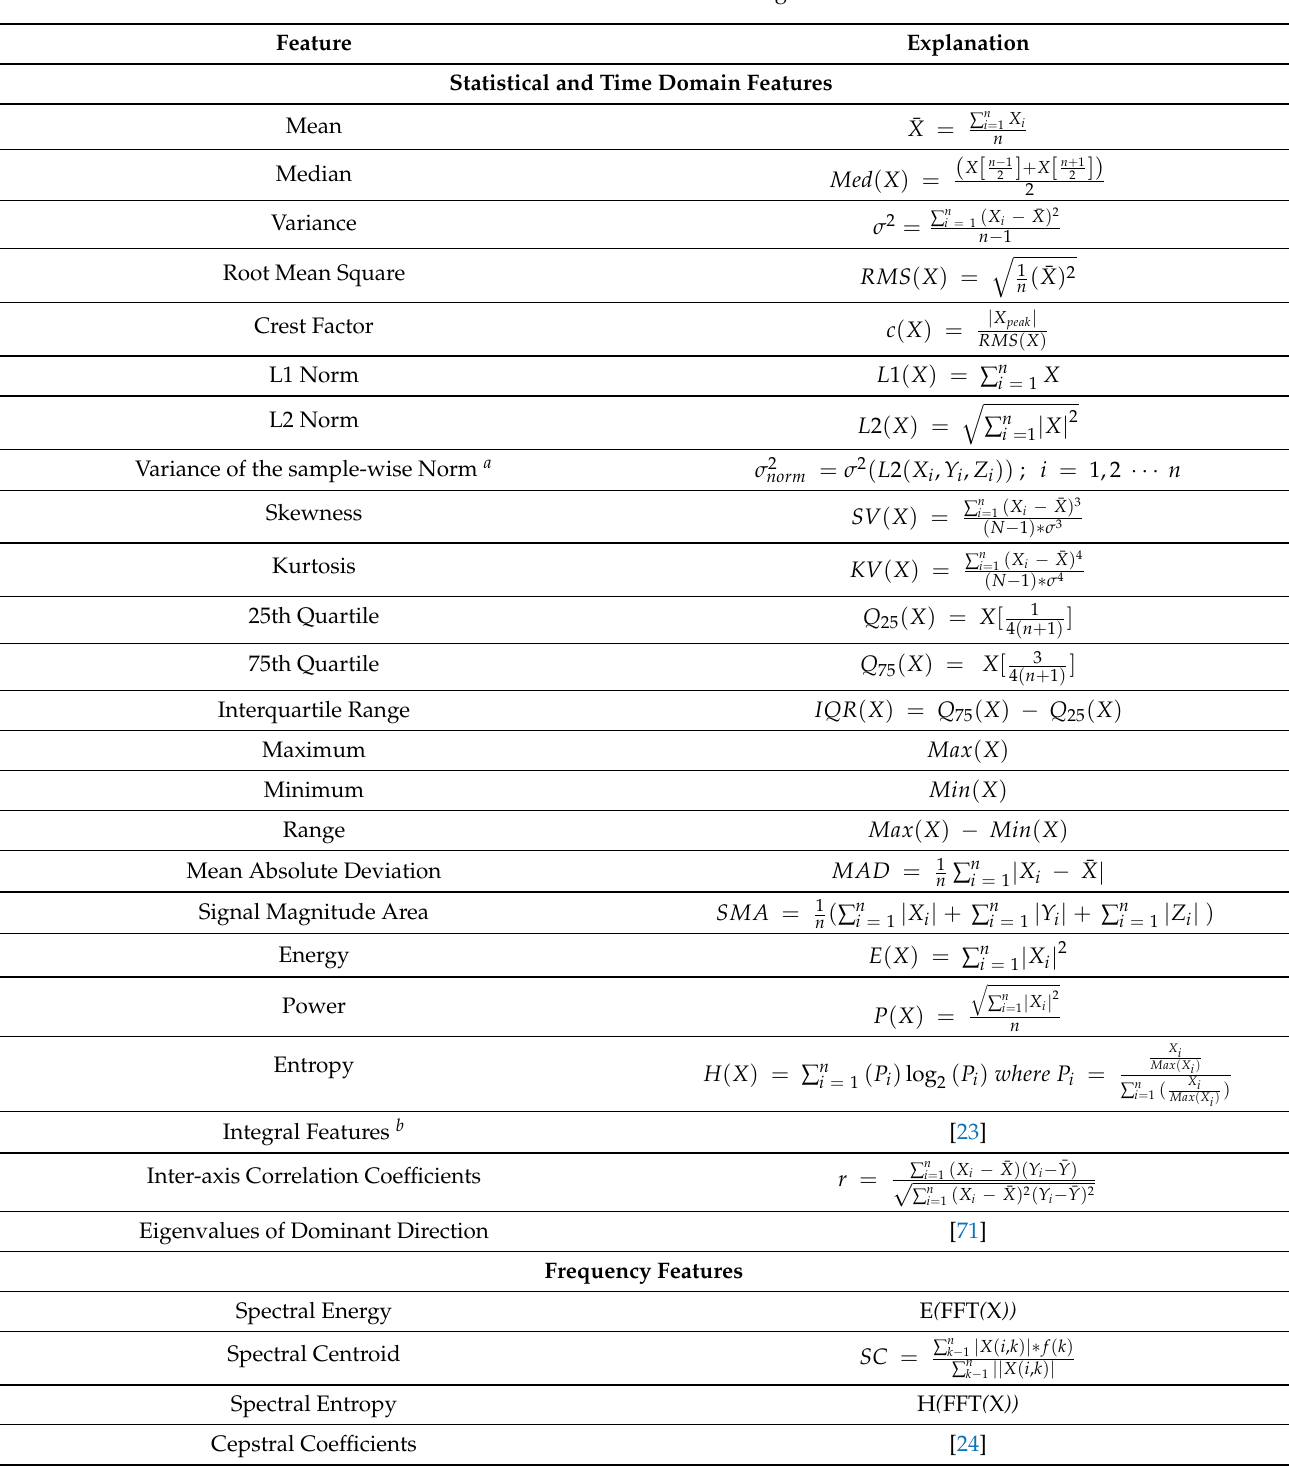
Table A1. Features used in